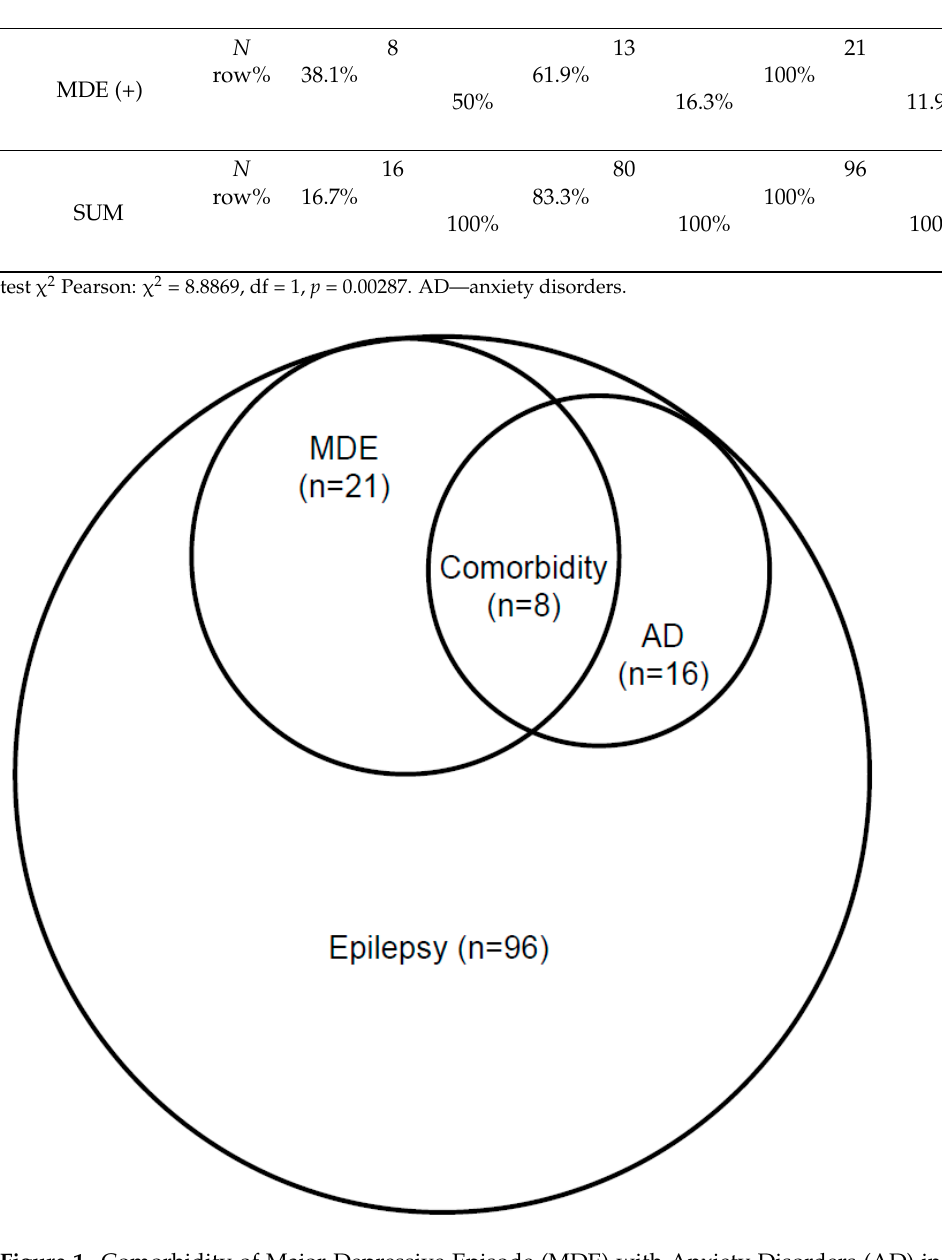
Figure 1. Comorbidity of Major Depressive Episode (MDE) with Anxiety Disorders (AD) in the group of epileptic patients ( n = 96); Pearson’s test ( χ 2 ): χ 2 = 8.8869, df = 1, p = 0.00287.